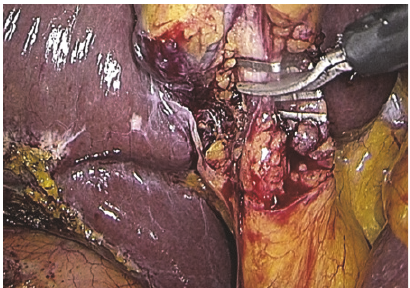
Figure 5: Bile rinsing.